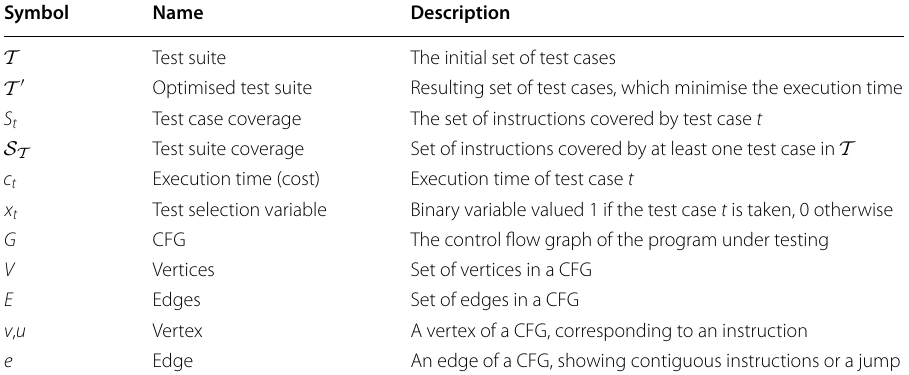
Table 1 Summary of the notation used in this paper Symbol